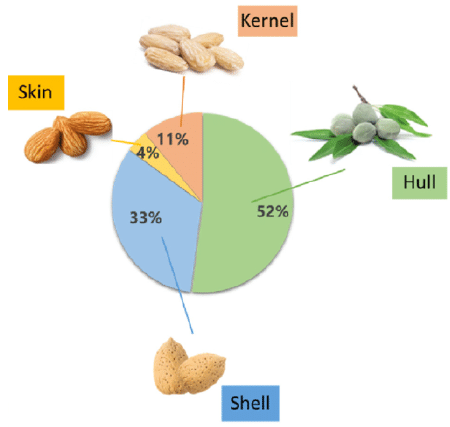
Figure 2. Weight proportion of the main structural parts of almond fruit